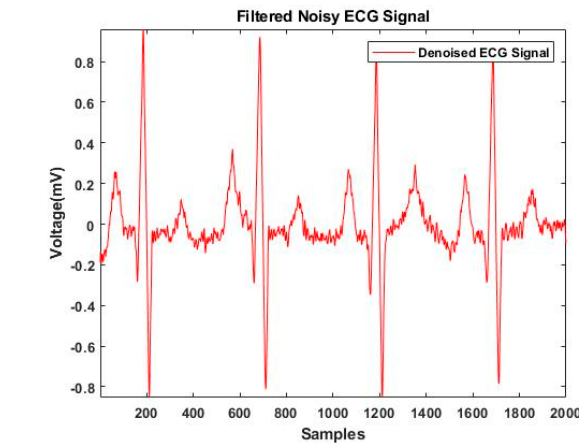
Figure 2. Noisy and denoised ECG signal.